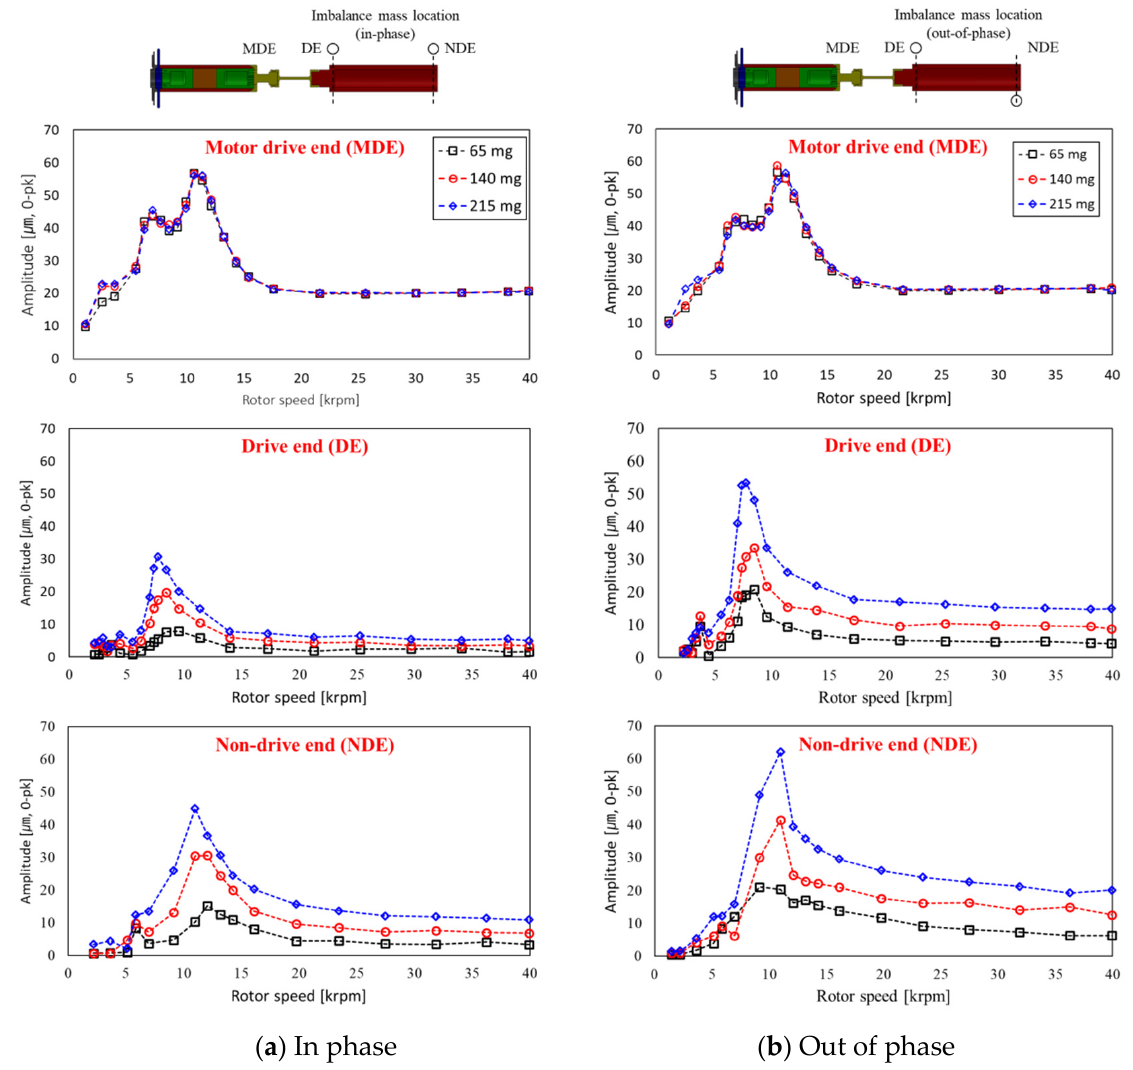
Figure A1. Filtered synchronous vertical motions measured at MDE and DE, NDE sides for ( a ) in phase and ( b ) out of phase imbalance mass.